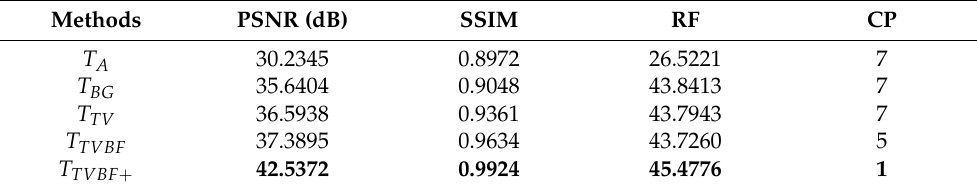
Table 3. The averaged evaluation indices of the 200 synthetic MWRI scenarios.